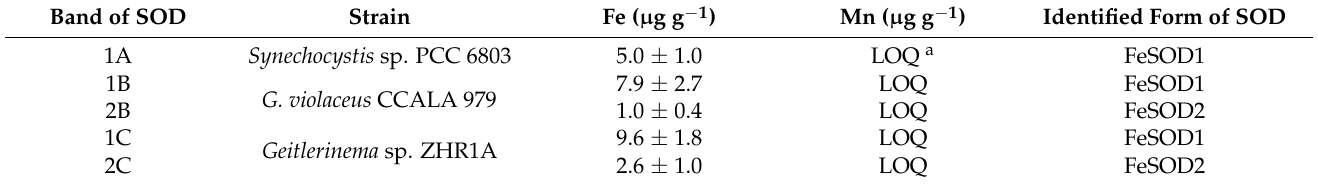
Table 1. Content of iron (Fe) and manganese (Mn) in the bands of SOD of the analyzed cyanobacteria using the atomic emission spectroscopy (AES) method. The data represent means ± SD ( n = 3).